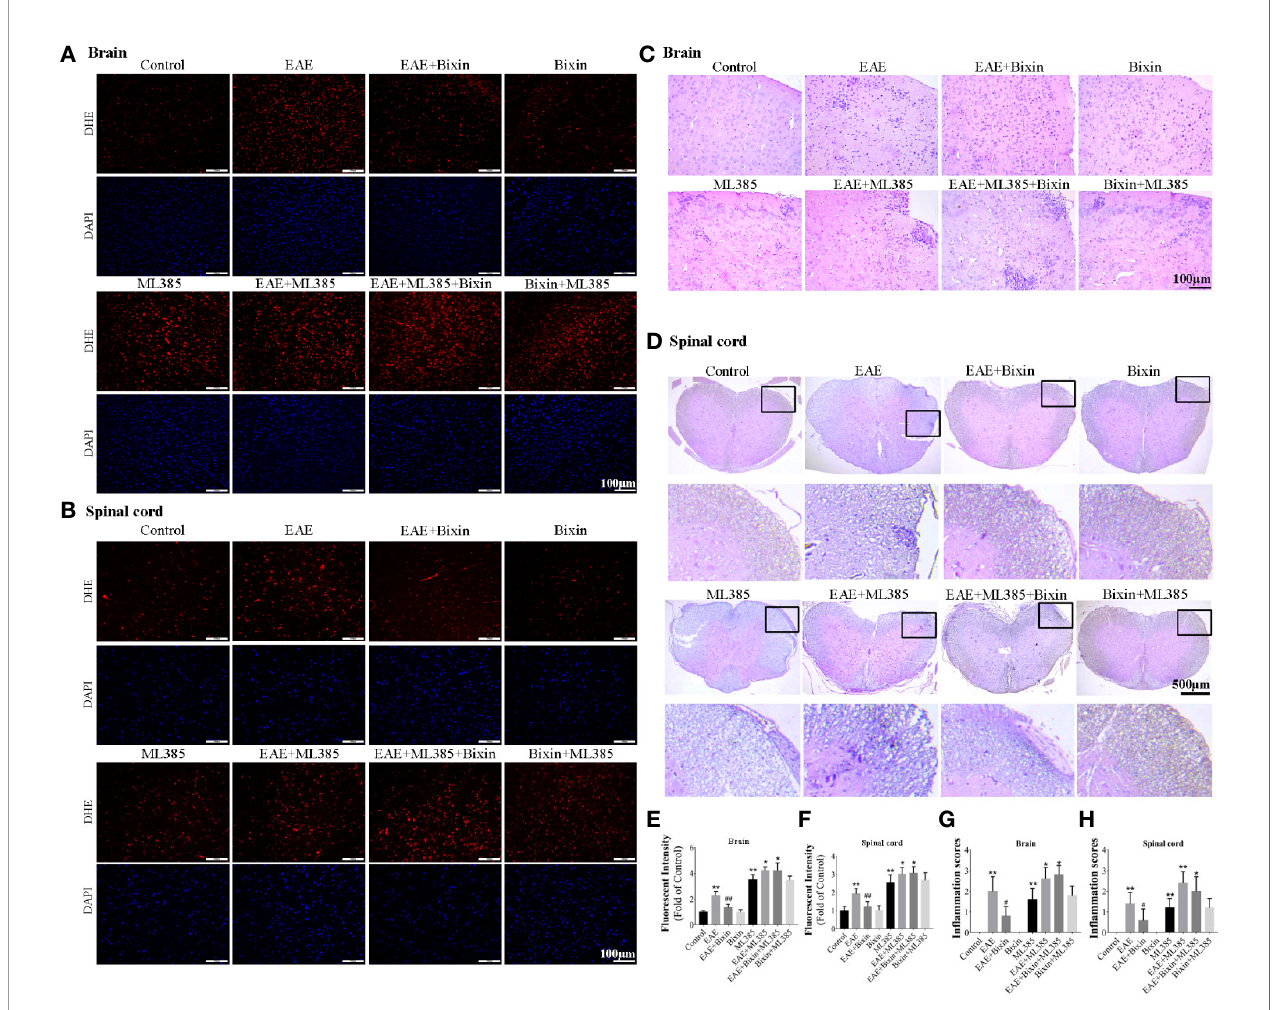
FIGURE 7 | Bixin suppressed the production of ROS and in fl ammation in EAE mice by activating NRF2 signaling. The level of reactive oxygen species (ROS) in the brain tissues (A) and spinal cord tissues (B) was assessed by DHE staining, as well as the quantitative results (E, F) . Scale bars: 100 m m. H&E staining showing in fl ammatory cell in fi ltration in the brain (C) (scale bars: 100 m m) and the spinal cord (D) (scale bars: 500 m m), as well as the in fl ammation scores (G, H) . Data shown in graphs represents the means ± SD (n = 5). *P < 0.05, **P < 0.01, vs. control group or ML385 group; # P < 0.05, ## P < 0.01, vs. EAE group or EAE + ML385